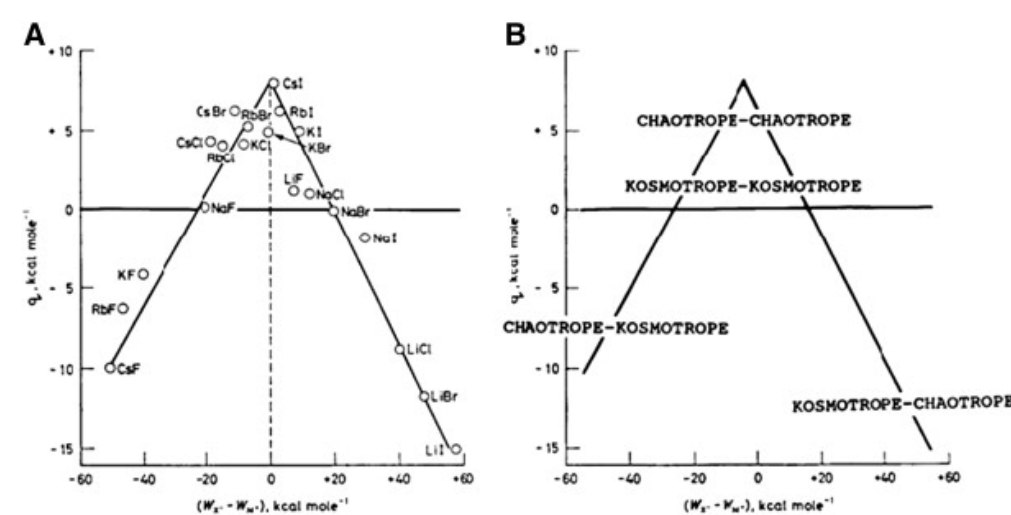
Figure 4. ( A ) Volcano plots for distinct combinations of alkali and halide ions with the corresponding calculated differences of the heats of hydration ∆∆ H hyd for the individual ions in gas phase ( x -axis), and the measured standard heats of solution Q s for the corresponding crystalline salts at infinite dilution in water ( y -axis). ( B ) Same plot such as in panel A, but now assigned to regions of distinct combinations of kosmotropic and chaotropic ions. Figure reproduced from Ref.